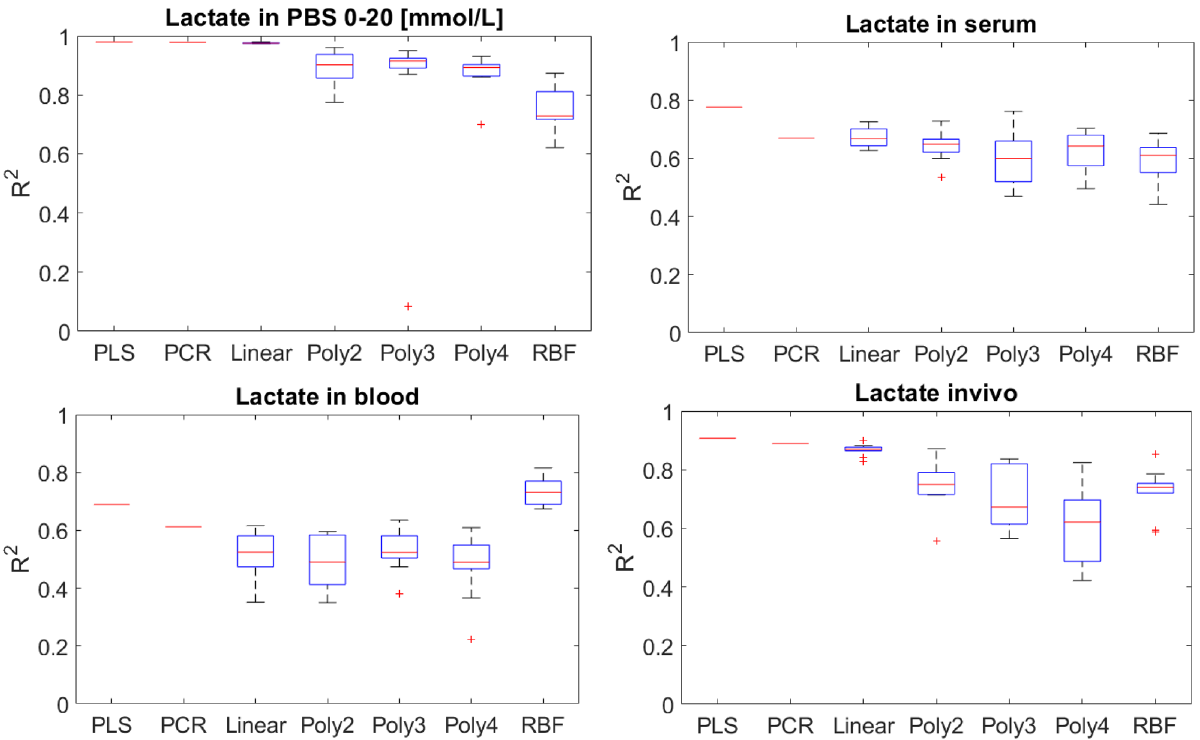
Figure 2. The comparison of the performance of linear and nonlinear models in increasingly more scattering matrices. The boxplots summarise the results pertaining to ten runs of cross-validation for each model. After 2 each run, an estimate of the coefficient of determination, R CV , is